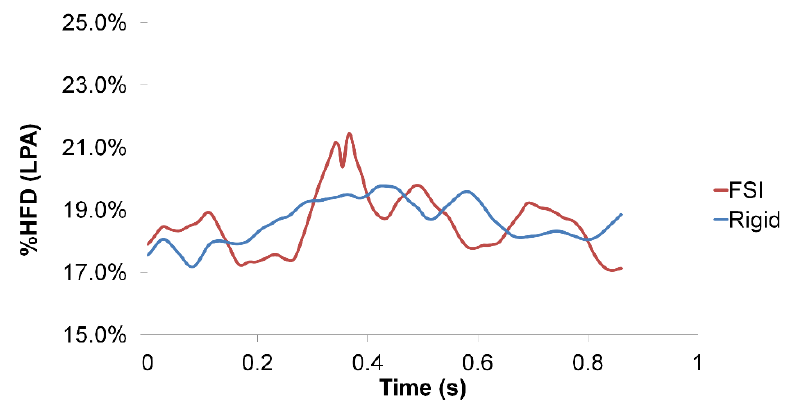
Figure 15. Hepatic flow distribution to the left pulmonary artery, %HFD(LPA), of the rigid wall and fluid-structure interaction (FSI) simulations within a cardiac cycle.